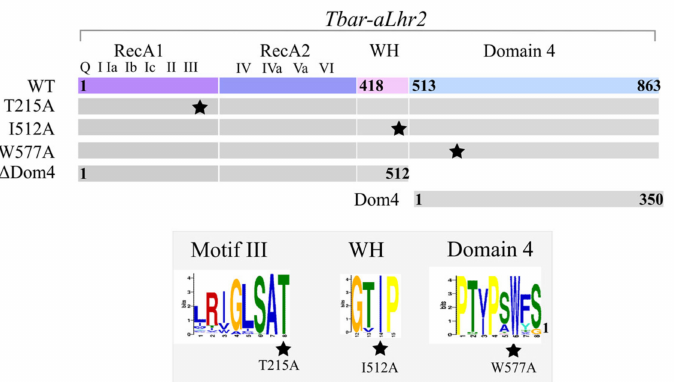
Figure 4. Domain organisation of wild-type Tbar -aLhr2 and derivatives. The colour code is as in Figure 3. Punctual mutations are represented by a star. The weblogos at the site of mutation are shown